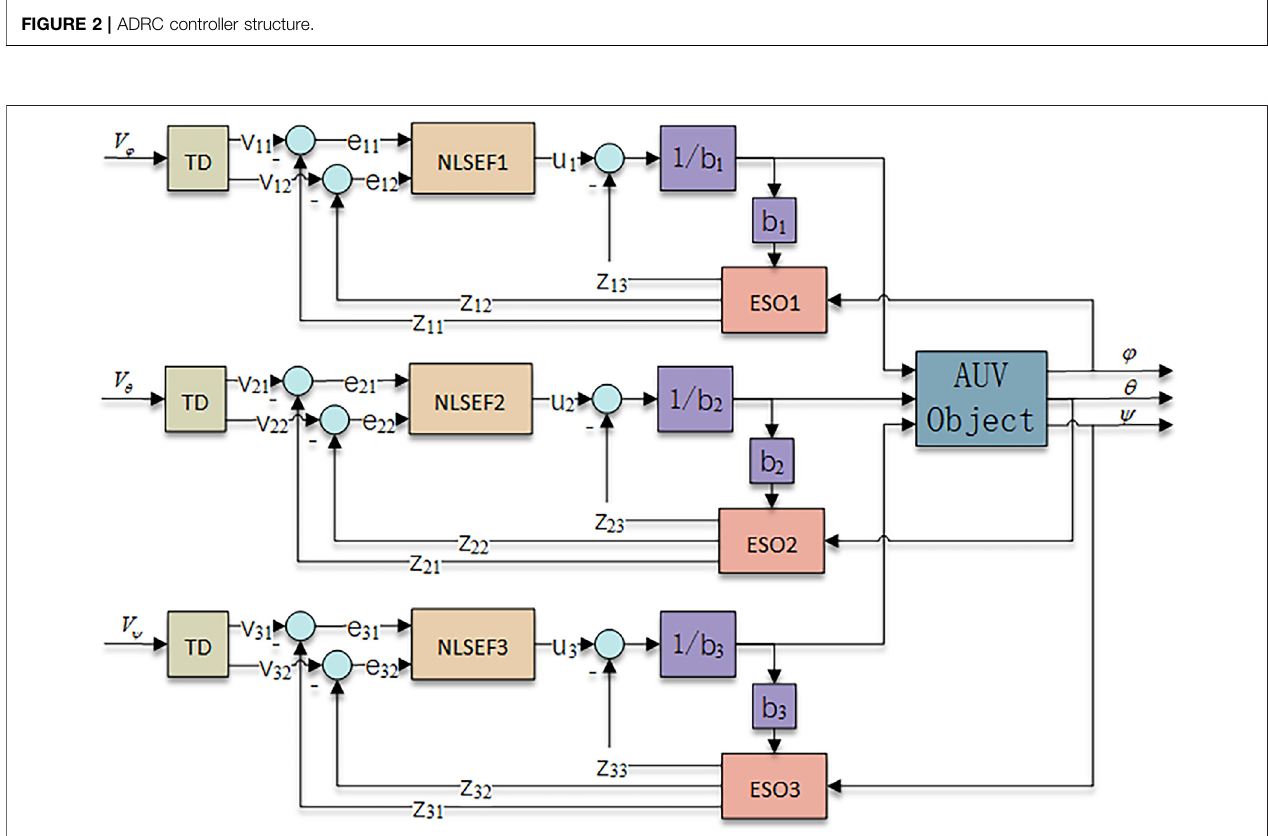
FIGURE 3 | ADRC attitude control structure